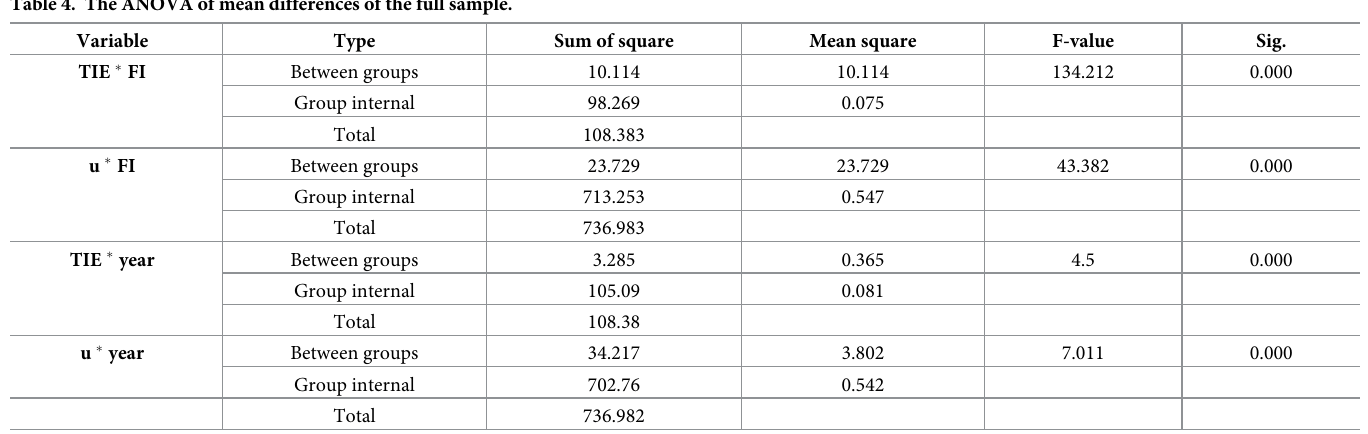
Table 4. The ANOVA of mean differences of the full sample.